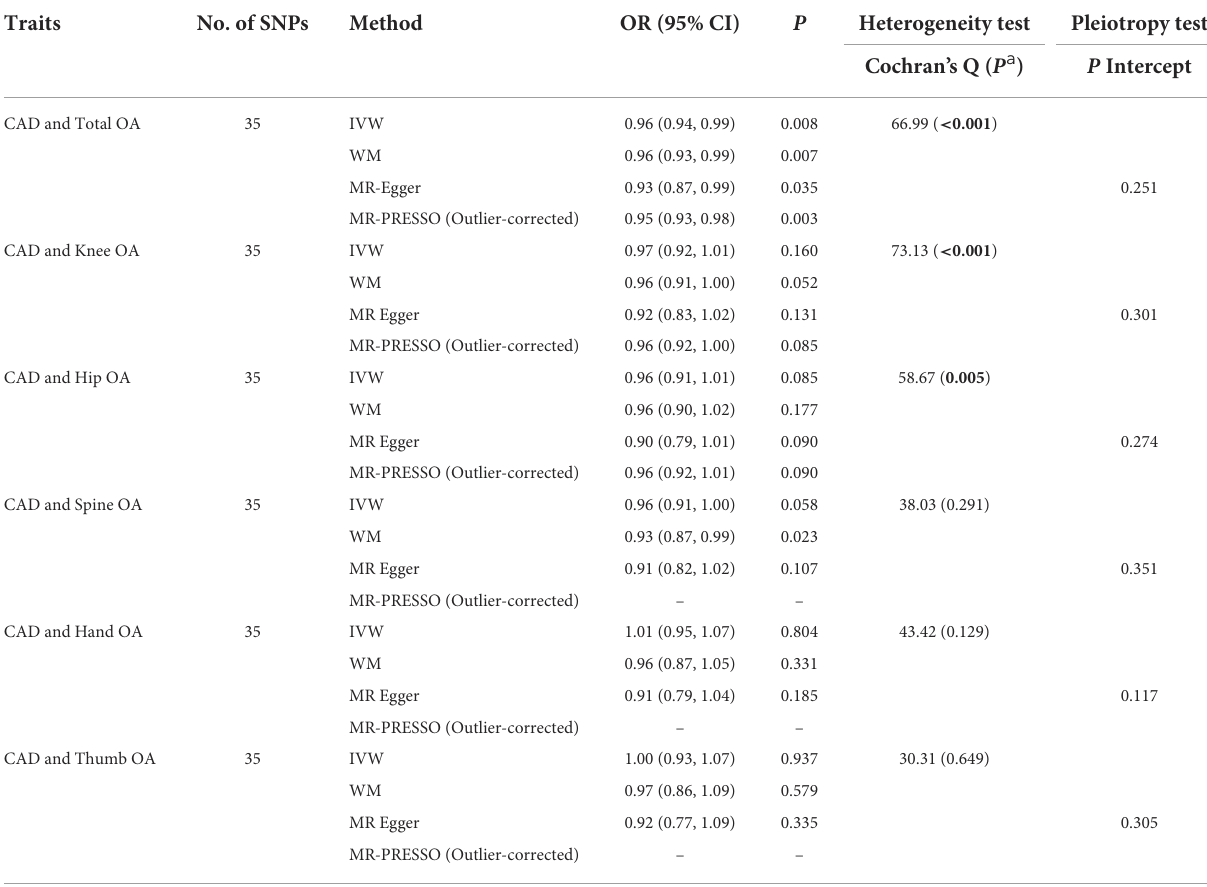
TABLE 4 MR results of the association between CAD and OA.